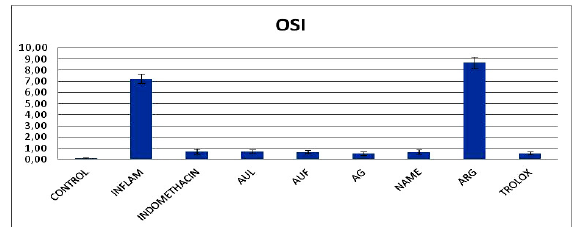
Fig. 3. Oxidative stress index